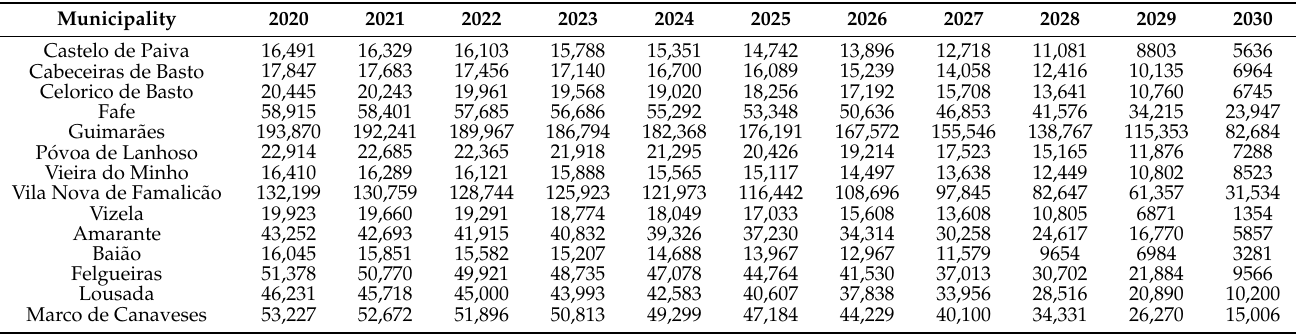
Table A5. Scenario 2: Impacts (available power–required power) of the BEV fleet on the grid during off-peak hours (values in